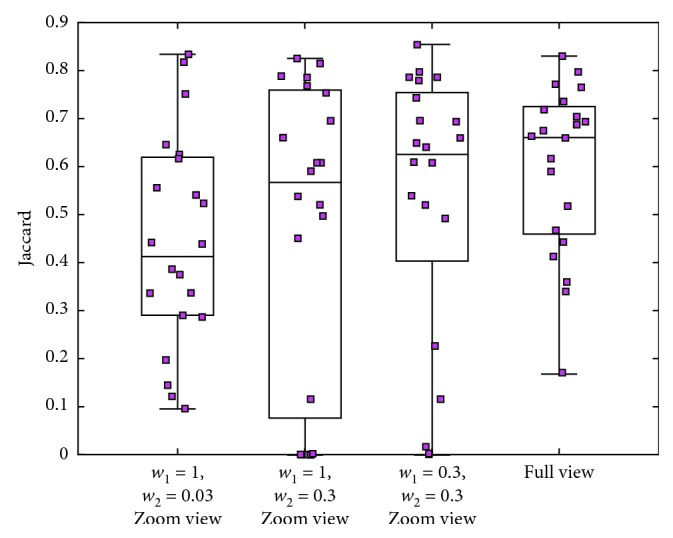
Jaccard values of zoom-view RFS2 at three different parameter combinations and full-view RFS1.